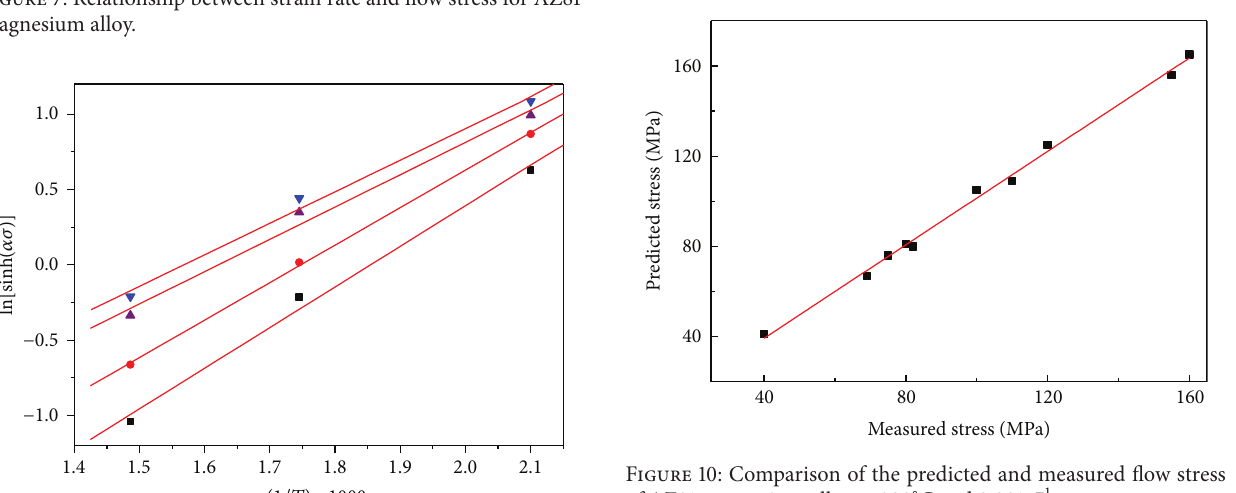
Figure 10: Comparison of the predicted and measured flow stress of AZ81 magnesium alloy at 300 ∘ C and 0.001s −1